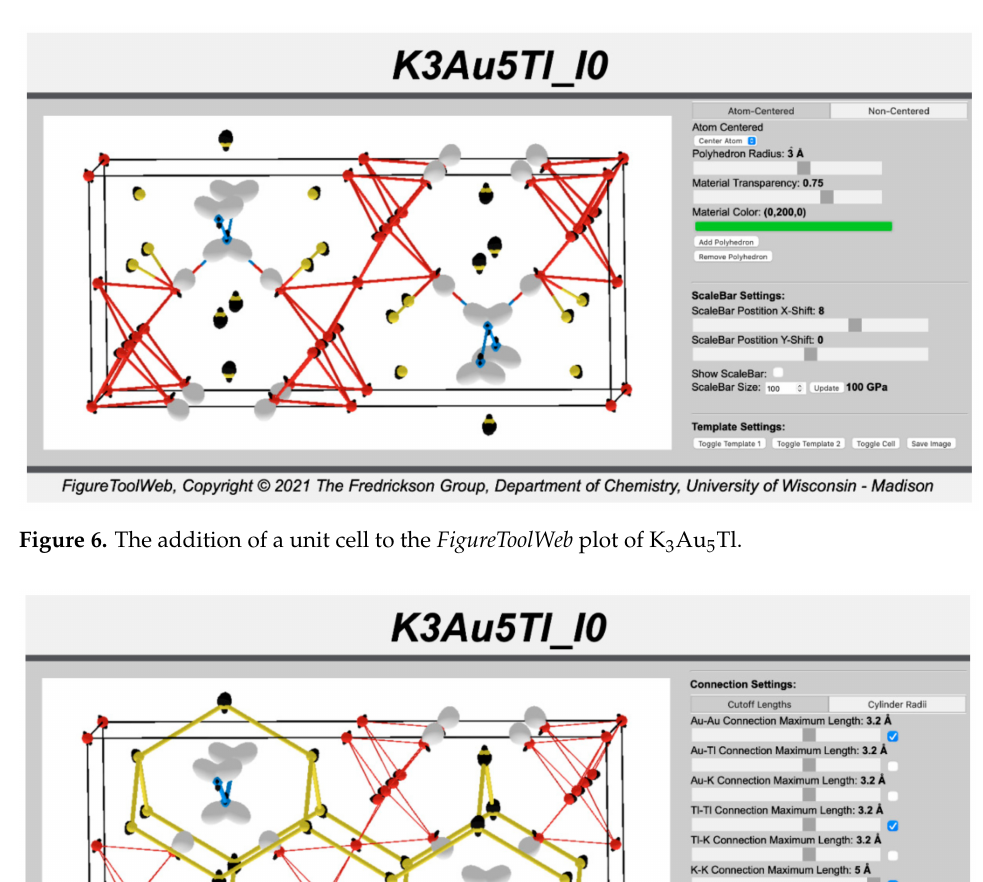
Figure 5. The CP scheme of K 3 Au 5 Tl as it appears when rendered with FigureToolWeb using a template file based on the conventional unit cell and the default visualization settings.